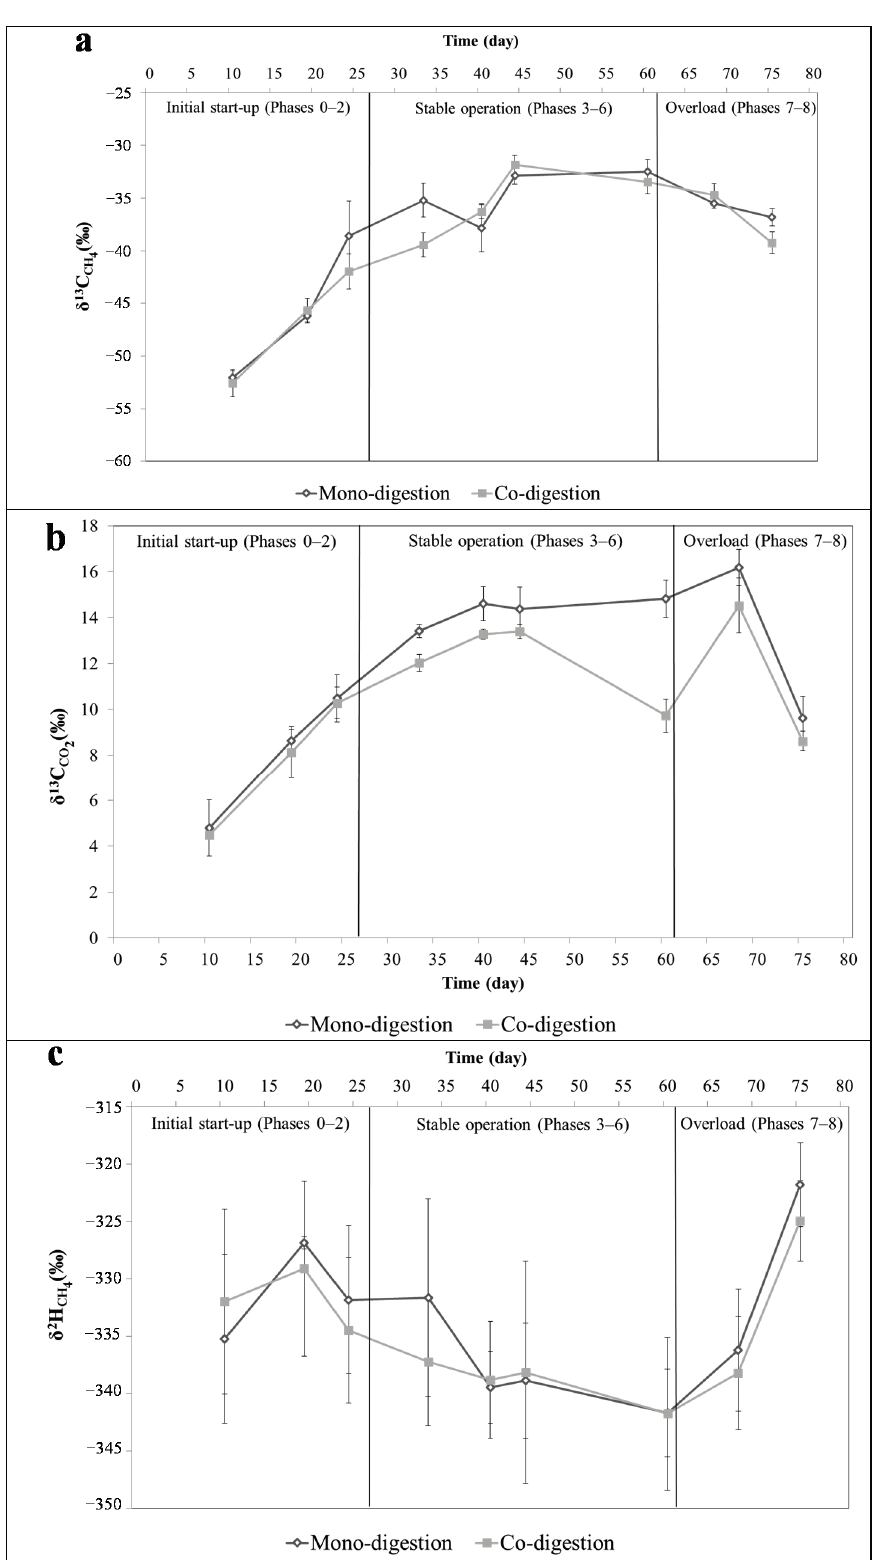
Figure 2. Isotopic dynamics of δ 13 C CH4 ( a ); δ 13 C CO2 ( b ); and δ 2 H CH4 ( c ) along gradual OLR increase in biogas reactors fed with sugarcane waste products. Isotope data of CO 2 during the last overload phase contains data uncorrected regarding the pH shift induced